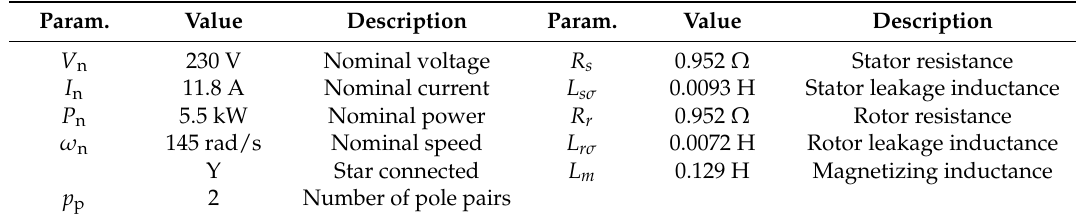
Table 3. Nominal values of the motor.